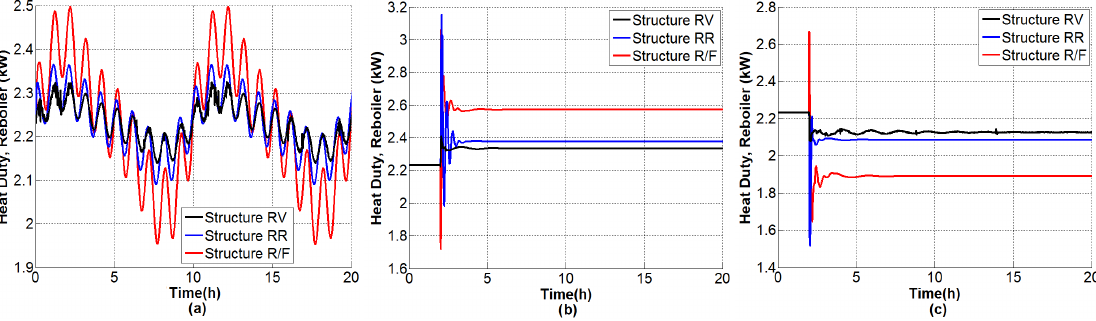
Figure 15. Reboiler energy consumption of the RV, RR and R/F control structures, assuming feed composition perturbations with ( a ) fluctuating input signal; ( b ) step of 10%; and ( c ) step of −